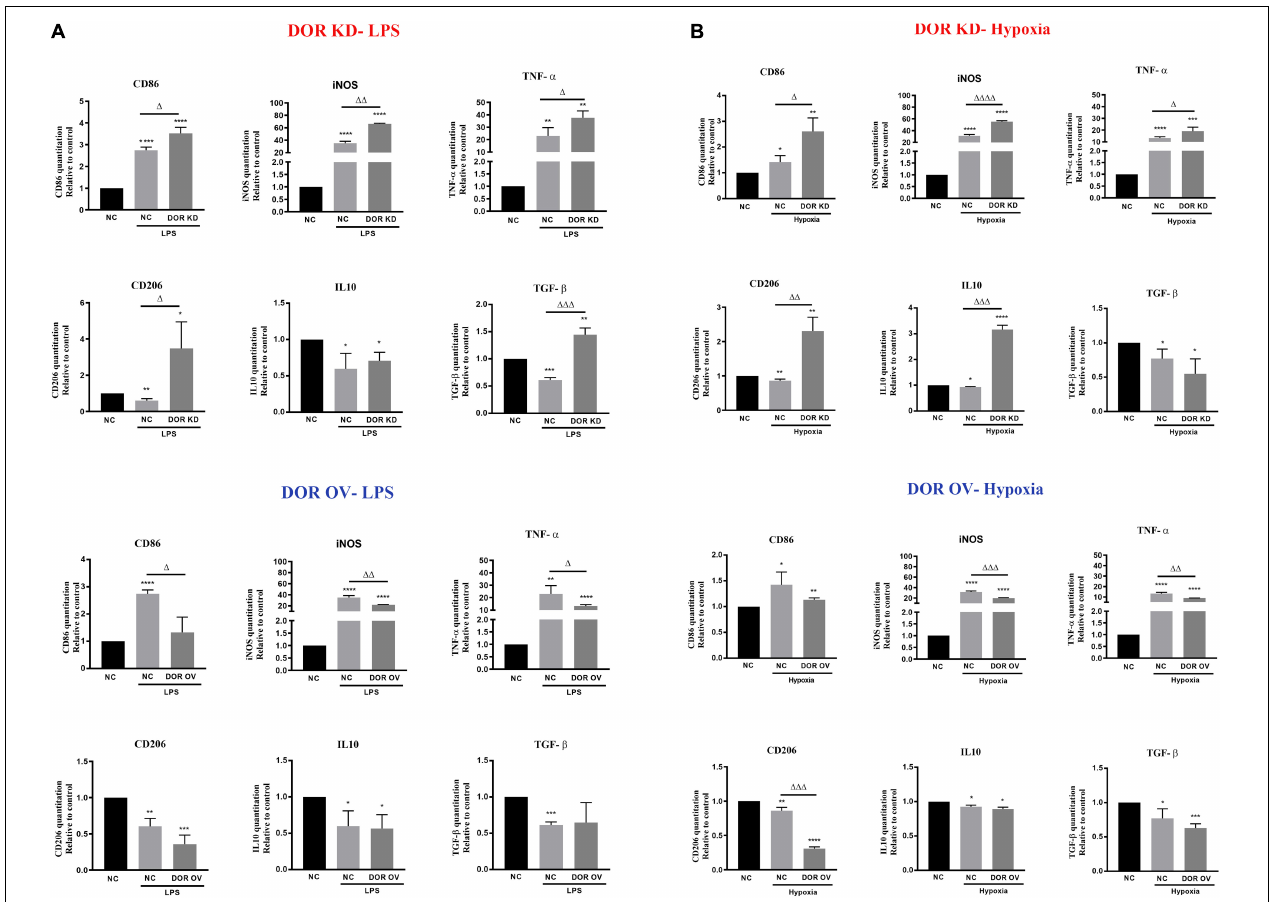
FIGURE 5 | δ -opioid receptor (DOR) knockdown and overexpression induced opposite effects on microglia-mediated inflammatory events. (A) Effects of DOR knockdown and overexpression on inflammatory cytokines under LPS insult. * p < 0.05, ** p < 0.01, *** p < 0.001, **** p < 0.0001 vs. NC; (cid:49) p < 0.05, (cid:49)(cid:49) p < 0.01, (cid:49)(cid:49)(cid:49) p < 0.001 vs. NC-LPS. Note that DOR knockdown aggravated the inflammatory situation induced by LPS, and it also promoted the anti-inflammatory events to fight against LPS injury. DOR overexpression largely downregulated LPS-induced generations of CD86, iNOS and TNF- α , while showed an inappreciable effect on CD206, IL-10 and TGF- β . (B) Effects of DOR knockdown or overexpression on inflammatory cytokines under hypoxic stress. * p < 0.05, ** p < 0.01, *** p < 0.001, **** p < 0.0001 vs. NC; (cid:49) p < 0.05, (cid:49)(cid:49) p < 0.01, (cid:49)(cid:49)(cid:49) p < 0.001, (cid:49)(cid:49)(cid:49)(cid:49) p < 0.0001 vs. NC-Hypoxia. Note that DOR knockdown in BV2 cells significantly increased both the inflammatory cytokines and anti-inflammatory cytokines level under hypoxic stress. DOR overexpression in BV2 cells suppressed the inflammatory events, and downregulated M2 phenotype marker CD206 as